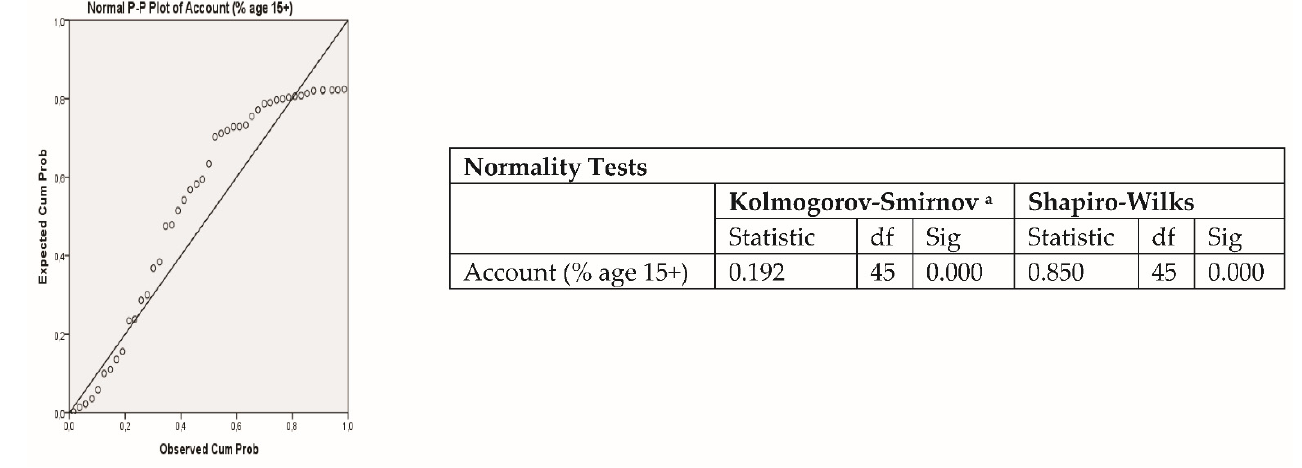
Figure 3. Normality of owning an account variable. a Lilliefors Significance Correction.